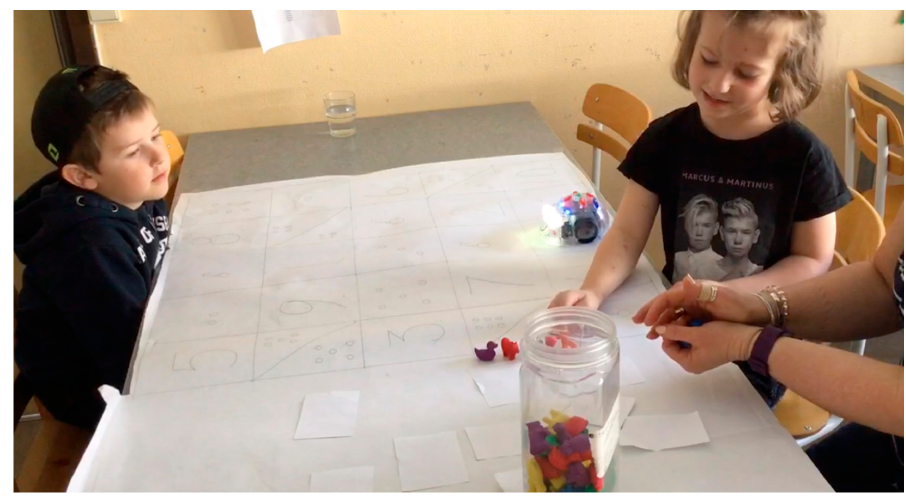
Figure 2. A digital programming session using a simple floor robot.